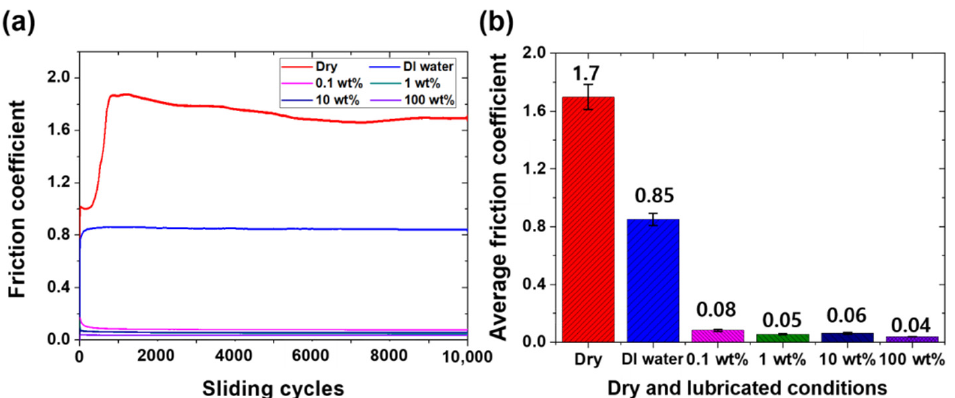
Figure 3. Friction characteristics of PDMS specimen under 100 mN normal load, dry, and lubricated conditions during 10,000 cycles. ( a ) Variation values of friction coefficient with respect to number of sliding cycles and ( b ) average values of friction coefficient.